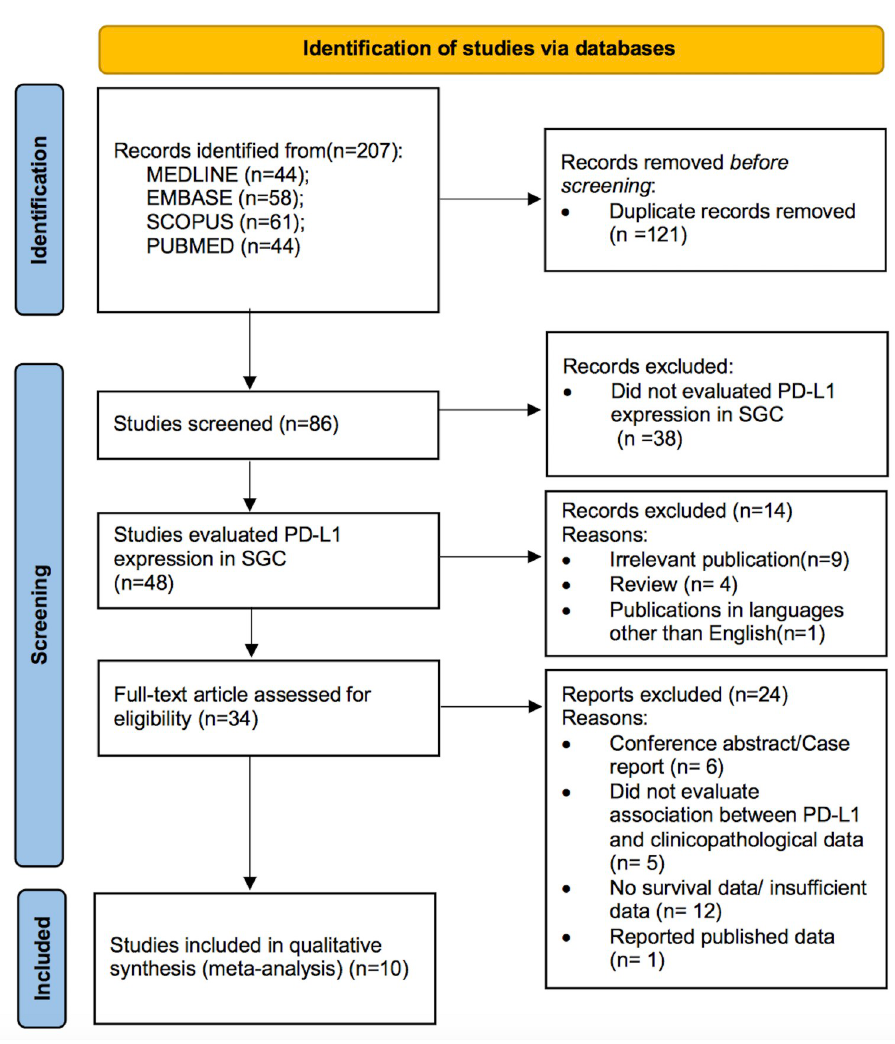
Fig 1. Flow chart of literature search and study